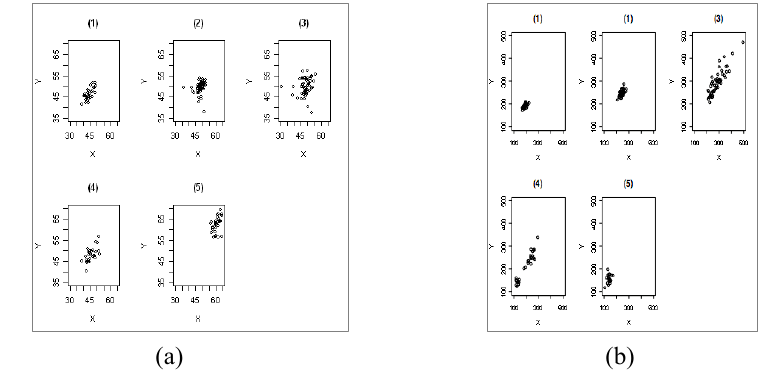
Figure 2. (a) Mean intensity of pretonic syllables perceived as bearing secondary stress (axis Y) and mean intensity of other pretonic syllables (axis X). (b) Mean F 0 of pretonic syllables perceived as bearing secondary stress (axis Y) and mean F 0 of other pretonic syllables (axis